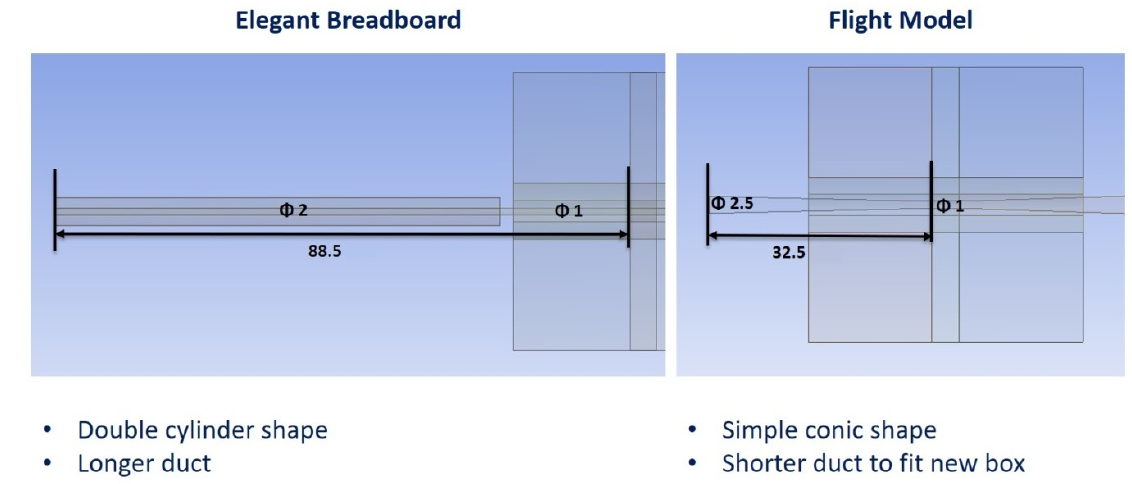
Figure 5. Geometry variations of MicroMED’s outlet duct (dimensions in mm) .